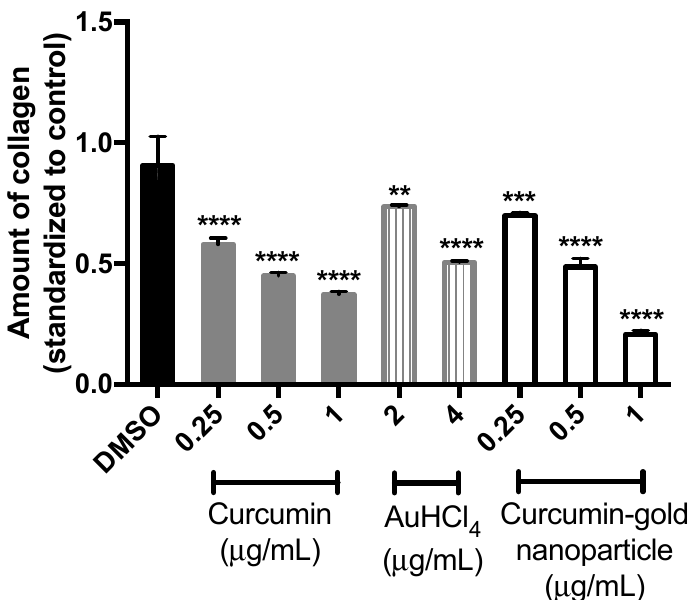
Figure 8. Effect of curcumin, AuHCl 4 , and curcumin-gold nanoparticles on the amount of collagen protein; n = 3; * p ≤ 0.05, ** p ≤ 0.01, *** p ≤ 0.001, **** p ≤ 0.0001.